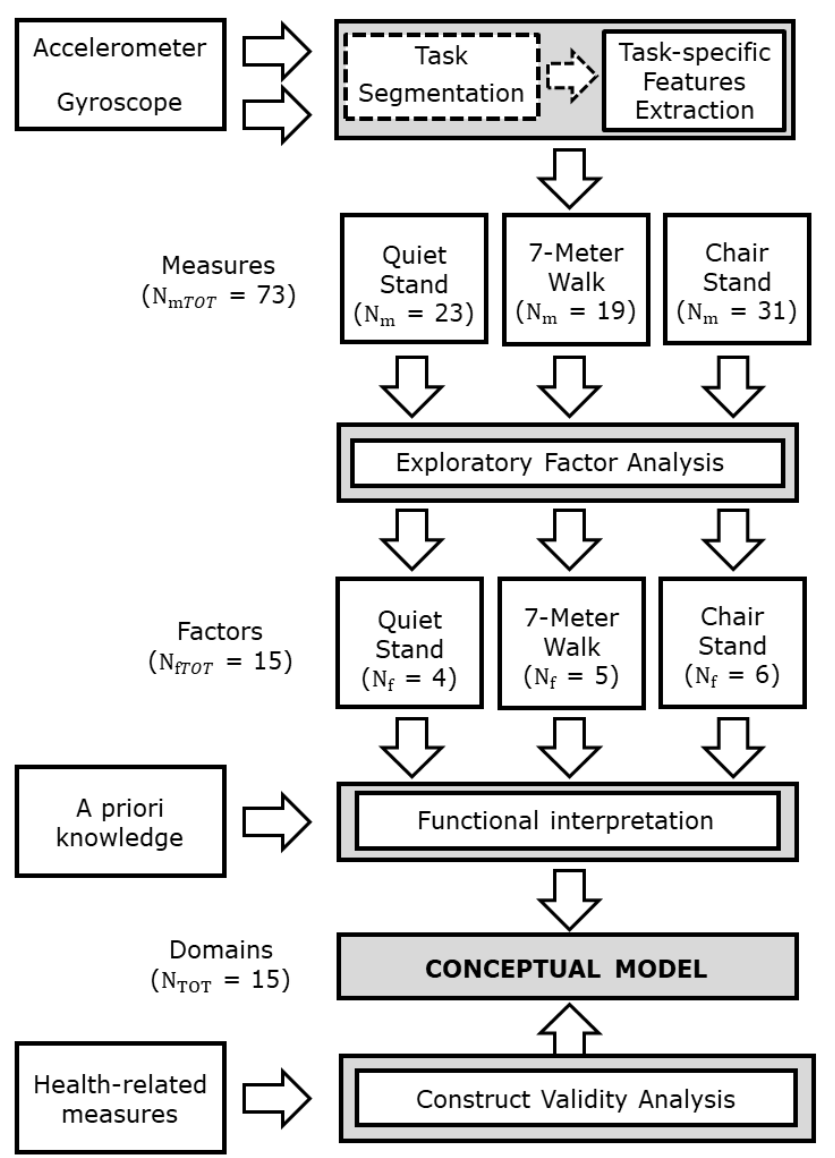
Figure 1. Flowchart of the conceptual model development process. N m is the number of sensor-based measures extracted from each test, N f is the number of factors and N TOT is the total number of domains constituting the conceptual model.